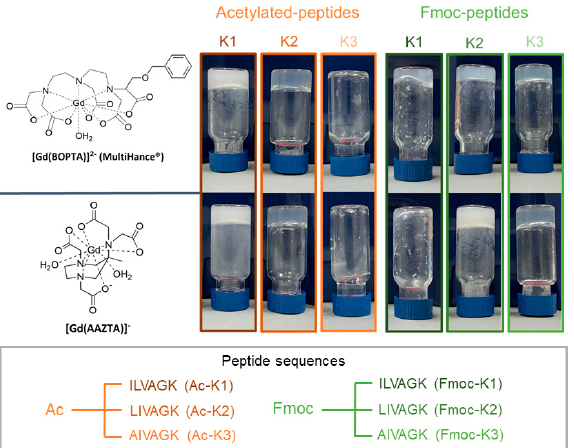
Figure 1. Schematic representation of peptide sequences according to the one code letter practice and of Gd(III) complexes ([Gd(BOPTA)] 2 − ) and [Gd(AAZTA)] − used for hydrogel formulations. For each combination, being peptide–Gd(III) chelates, the inverted test tube is also reported.